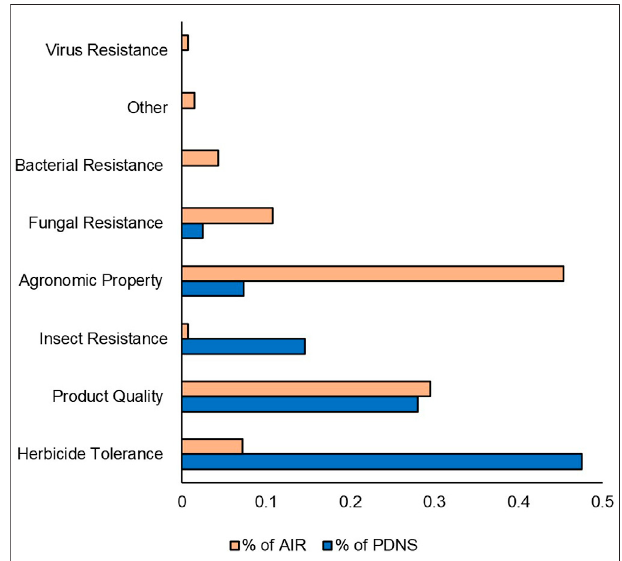
FIGURE 5 | Developer comparison. Percentages indicate the share of the total number of times that category occurred in the data set. Comparison is from 2011 to 2020.